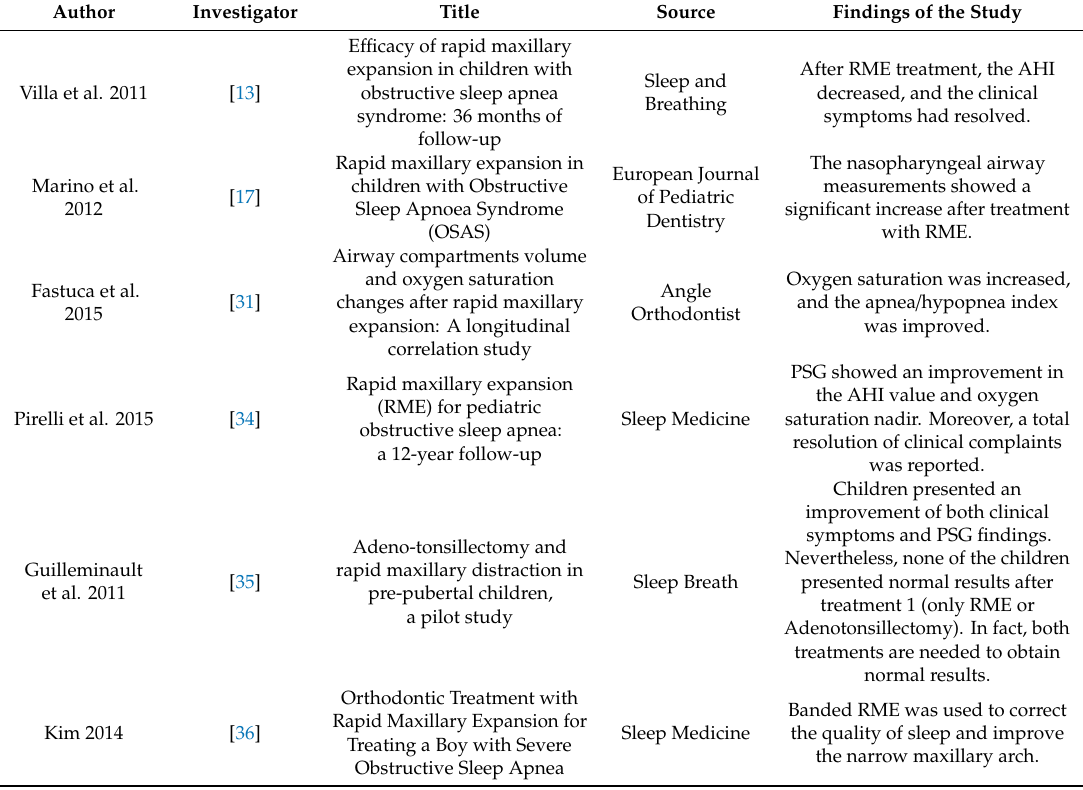
Table 1. Literature review (tabular